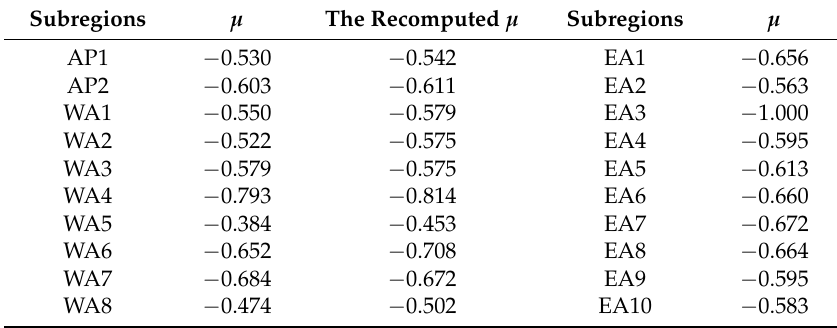
Table 3. The optimal values of µ for each subregions. The recomputed µ values using low rock densities of 2000 kg/m 3 in the Antarctic Peninsula (AP) and of 2200 kg/m 3 in West Antarctica (WA), which are computed by the viscoelastic response function [79] in consideration of a thin lithosphere and low viscosity in these